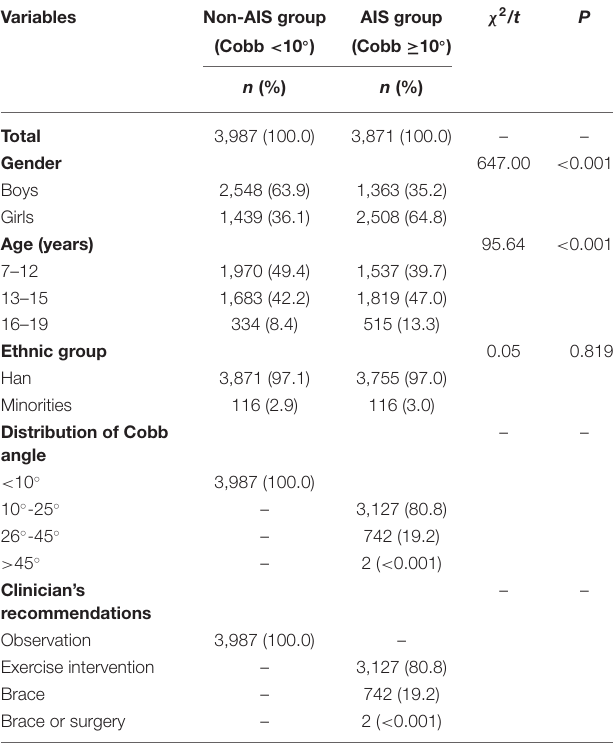
TABLE 1 | Demographic characteristics of participants stratified by the occurrence of AIS ( N =